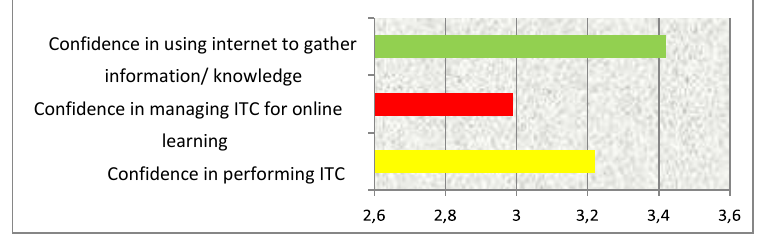
Figure 2. Students' readiness in computer/ internet self-efficacy